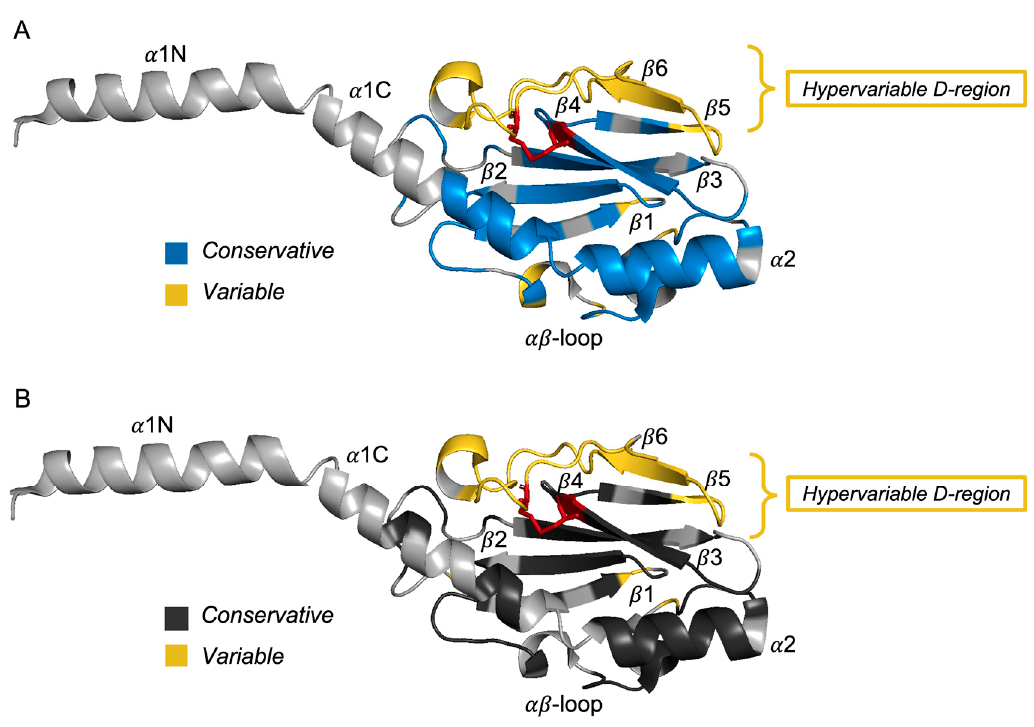
Figure 2. Structural mapping of N. gonorrhoeae PilE (PDB: 2HI2) conserved and variable amino acid positions corresponding to Jalview numerical indexes. Conservative positions are shown in blue or dark gray for ngmutS - ( A ) and ngmutL -deficient isolates ( B ), respectively. Variable positions are shown by yellow.